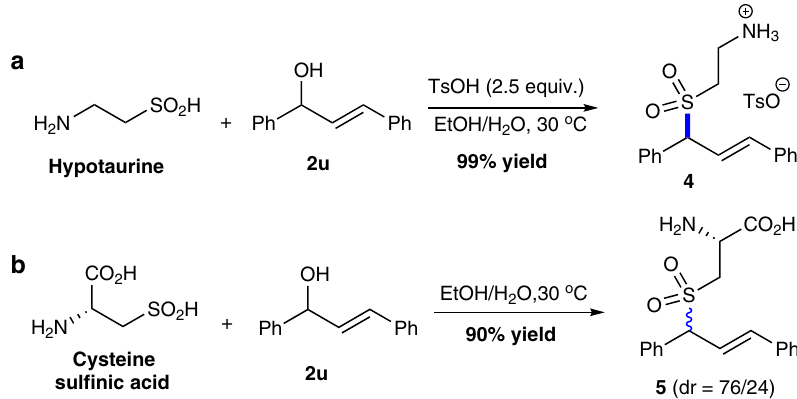
Fig. 4 Direct allylation of hypotaurine and cysteine sul fi nic acid. a TsOH (4-methylbenzenesulfonic acid) was believed to destroy intramolecular hydrogen bonding of Hypotauring. b The dr value of 5 was determined by 1 H NMR